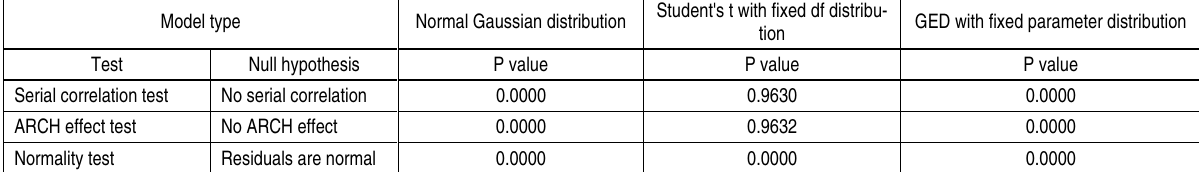
Table 5. Result of model selection for the APARCH (1,1